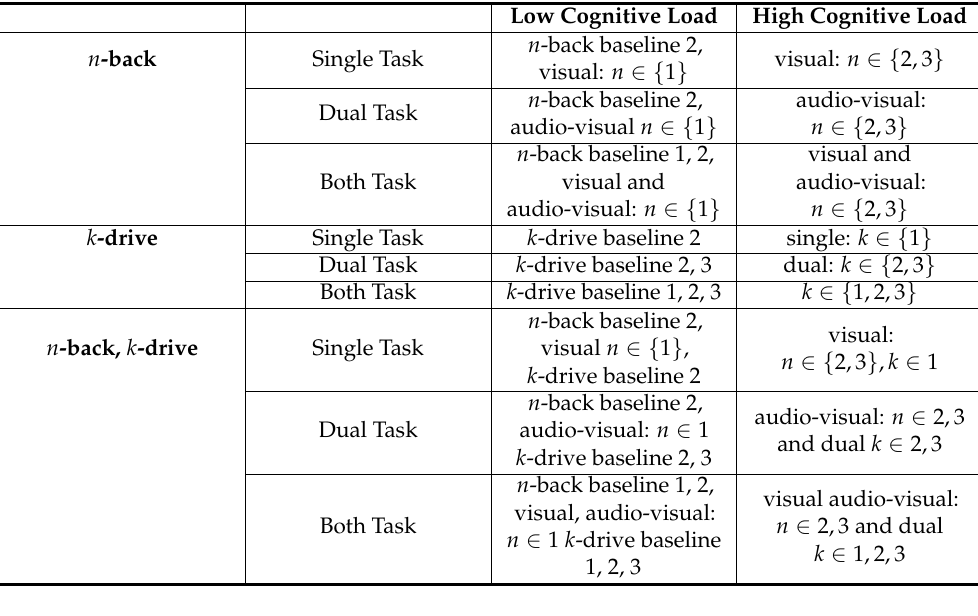
Table A2. Tabular visualization of groups of experiments and levels used in our binary classification task. Described in greater detail in Section 2.4 we denote the n -back baseline 1 as resting phase and n -back baseline 2 as the tutorial phase. The baselines for k -drive are described in Section 2.3, where k -drive baseline 1 is resting, baseline 2 is tutorial-driving-observation and baseline 3 is